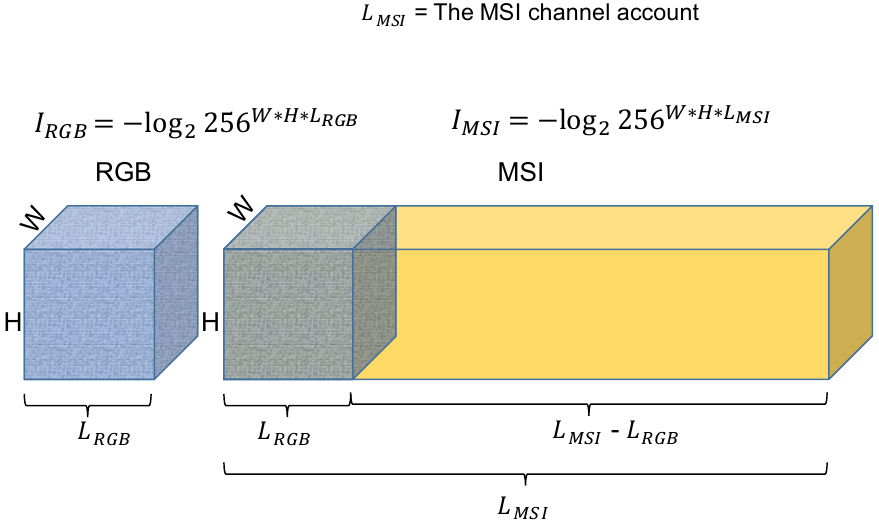
Figure 3. The difference of RGB and MSI image information